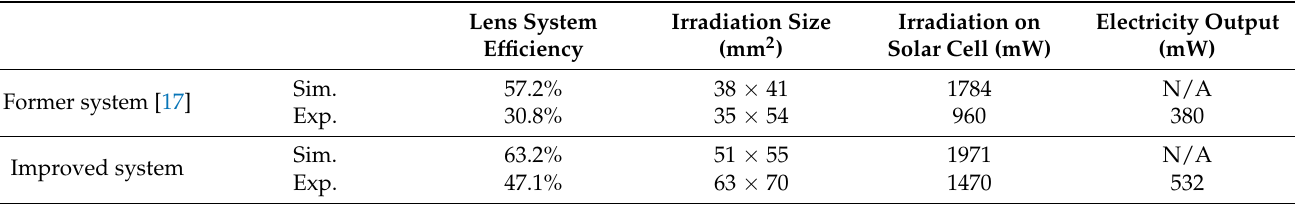
Table 4. Simulation (sim.) and experimental results (exp.) of the former and improved systems. Lens System Former system [17] Improved Sim. Improved system